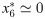
Control strategies applied to the microbiota dataset.Panel (a): a reduced 5 species subsystem of the microbiota is considered (case A) and all possible fixed points computed. Only those displaying non-negative concentrations are retained and their stability assessed. In the main figure, the histogram of (λRe)max, the largest real parts of the eigenvalues obtained after the linear stability analysis, is depicted. The two pie charts refer to the initially unstable fixed point (upper chart) and the stabilized equilibrium (lower chart). Panel (b): the root loci diagram relative to the case discussed in panel (a), is shown. Blue circles identify the position of the complex eigenvalues when ρ = 0, while green crosses stand for the eigenvalues obtained in the limit ρ → ∞. The vertical red line is the asymptote that eventually attracts the two residual eigenvalues. The red dots show the computed spectrum, when progressively increasing ρ. Panel (c): the goal is here to reduce the concentration of the pathogen species, C. difficile, by employing as controller one of the species that compose the microbioma (case B). The concentration of C. difficile is monitored over time for three different control strategies, turning on the control at the same time (t = 20 days). The insertion of the species of uncl. Lachnospiraceae provoques a substantial reduction (50%) of the pathogen concentration, as also displayed by the enclosed pie charts (for interpreting the color-code refer to panel (a)). Panel (d): we now modify a stable fixed point, by driving to extinction one of the existing population, the pathogen C. difficile (here species 6), with an indirect control strategy (case C). The obtained concentrations are reported in the left graph (pluses) and confronted with the initial unperturbed solution (diamonds). As anticipated x6*≃0. The components of α are plotted in the right graph. Notice in particular that α6 = 0.